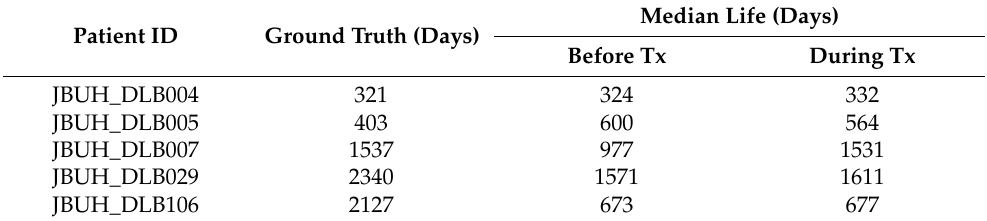
Table 4. Example predictions for patients with survival times in the range of 527–2421 days.